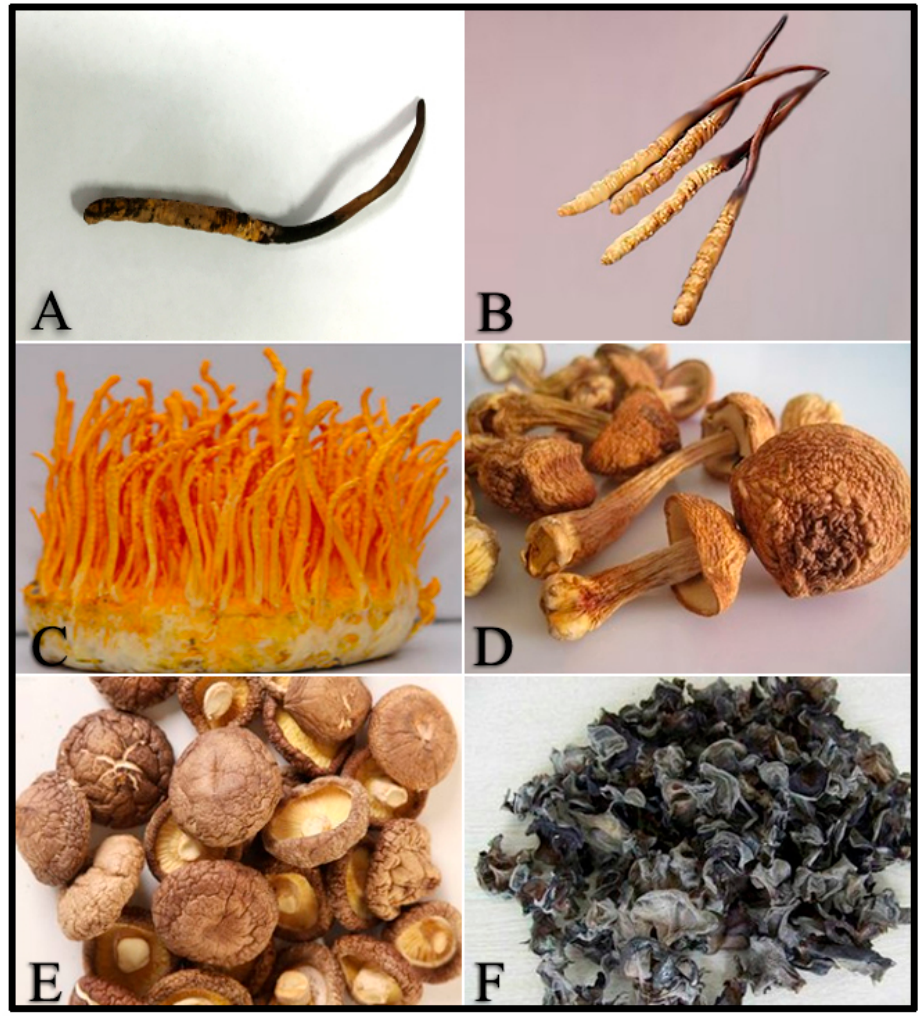
Figure 1. Morphological characters of the samples for this study. ( A ) wild Ophiocordyceps sinensis , ( B ) cultivated Ophiocordyceps sinensis , ( C ) Cordyceps militaris , ( D ) Agaricus blazei , ( E ) Lentinus edodes , and ( F ) Auricularia auricula .